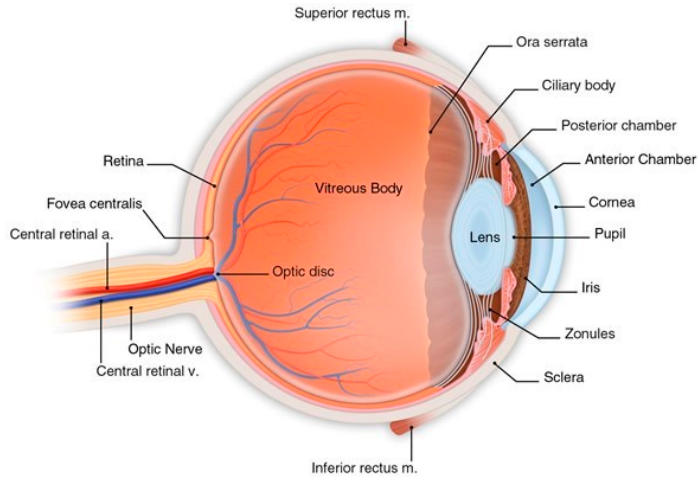
Figure 1. Anatomy of the eye (© 2020 American Academy of Ophthalmology) [12].